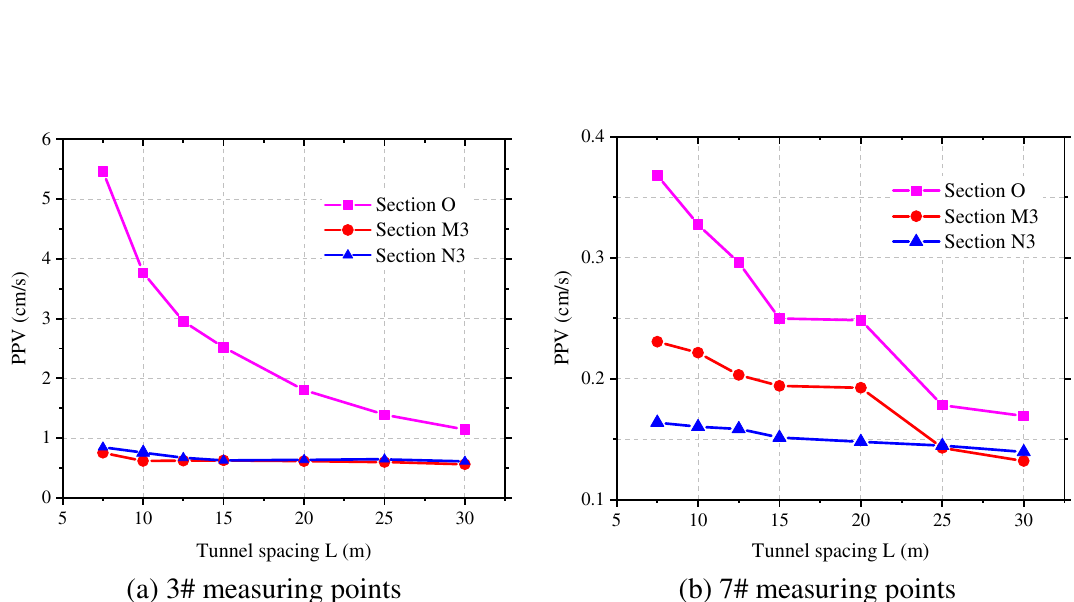
Figure 8. Radial PPV of measuring points 3# and 7# at different tunnel